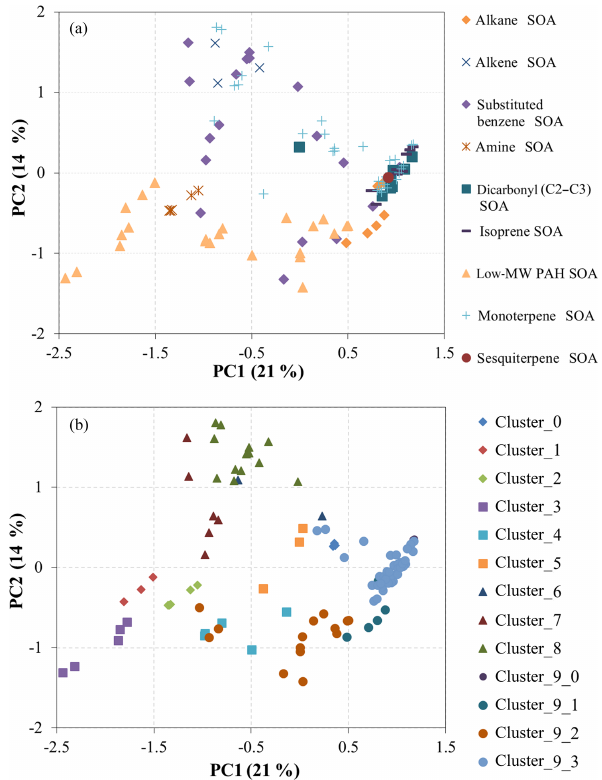
Figure 1. PCA score plot of 104 aerosol compounds: compounds marked according to different SOA classes (a) and compounds marked according to different clusters (b) .